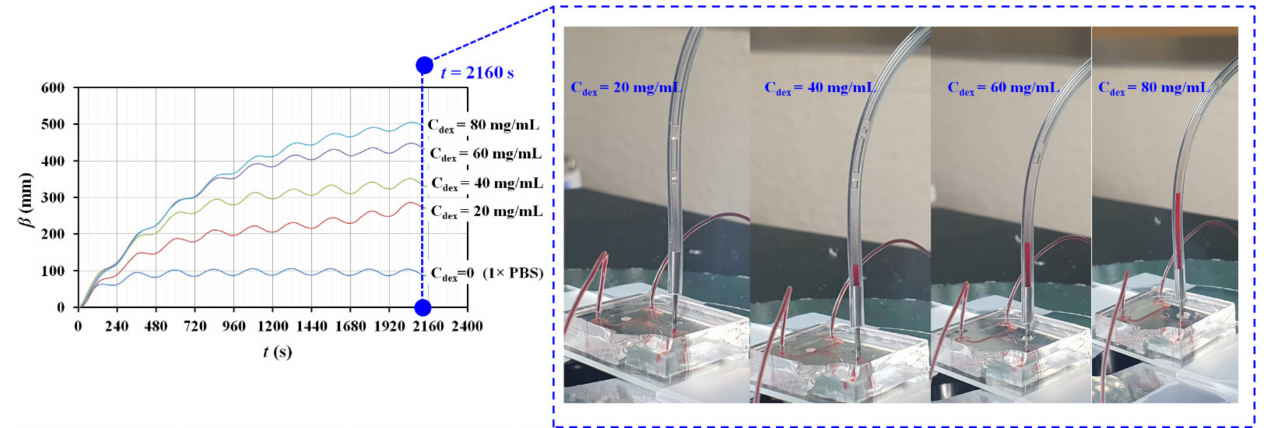
Figure A1. Temporal variations of β with respect to concentration of dextran solution (C dex ) (C dex = 0, 20, 40, 60, and 80 mg/mL). At the end duration of blood delivery ( t = 2160 s), four snapshots for showing volume of blood (C dex = 20, 40, 60, and 80 mg/mL) filled in the ACU were represented in the right-side